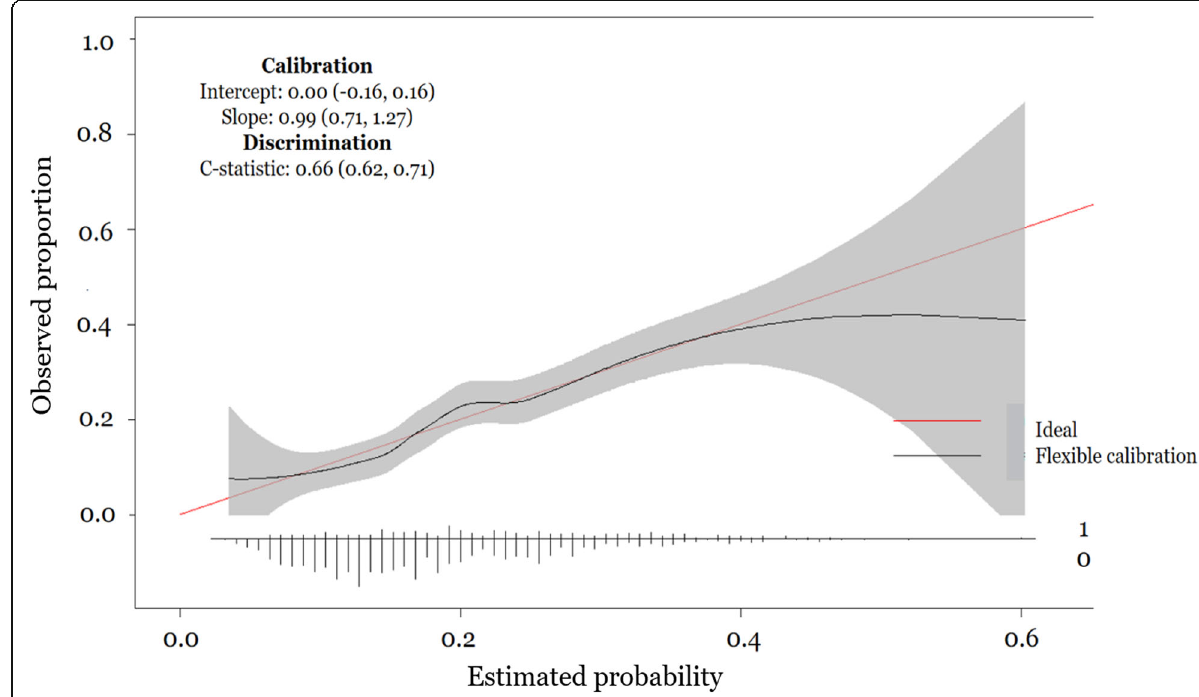
Fig. 3 Calibration plot ( N = 1752) of the developed prognostic model with loess smoother. The distribution of the estimated probabilities is shown at the bottom of the graph, by status relapse within 2 years (i.e. events and non-events). The horizontal axis represents the expected probability of relapsing within the next 2 years and the vertical axis represents the observed proportion of relapse. The apparent performance measures (c-statistic and c-slope) with their correspondent 95% CI are also shown in the